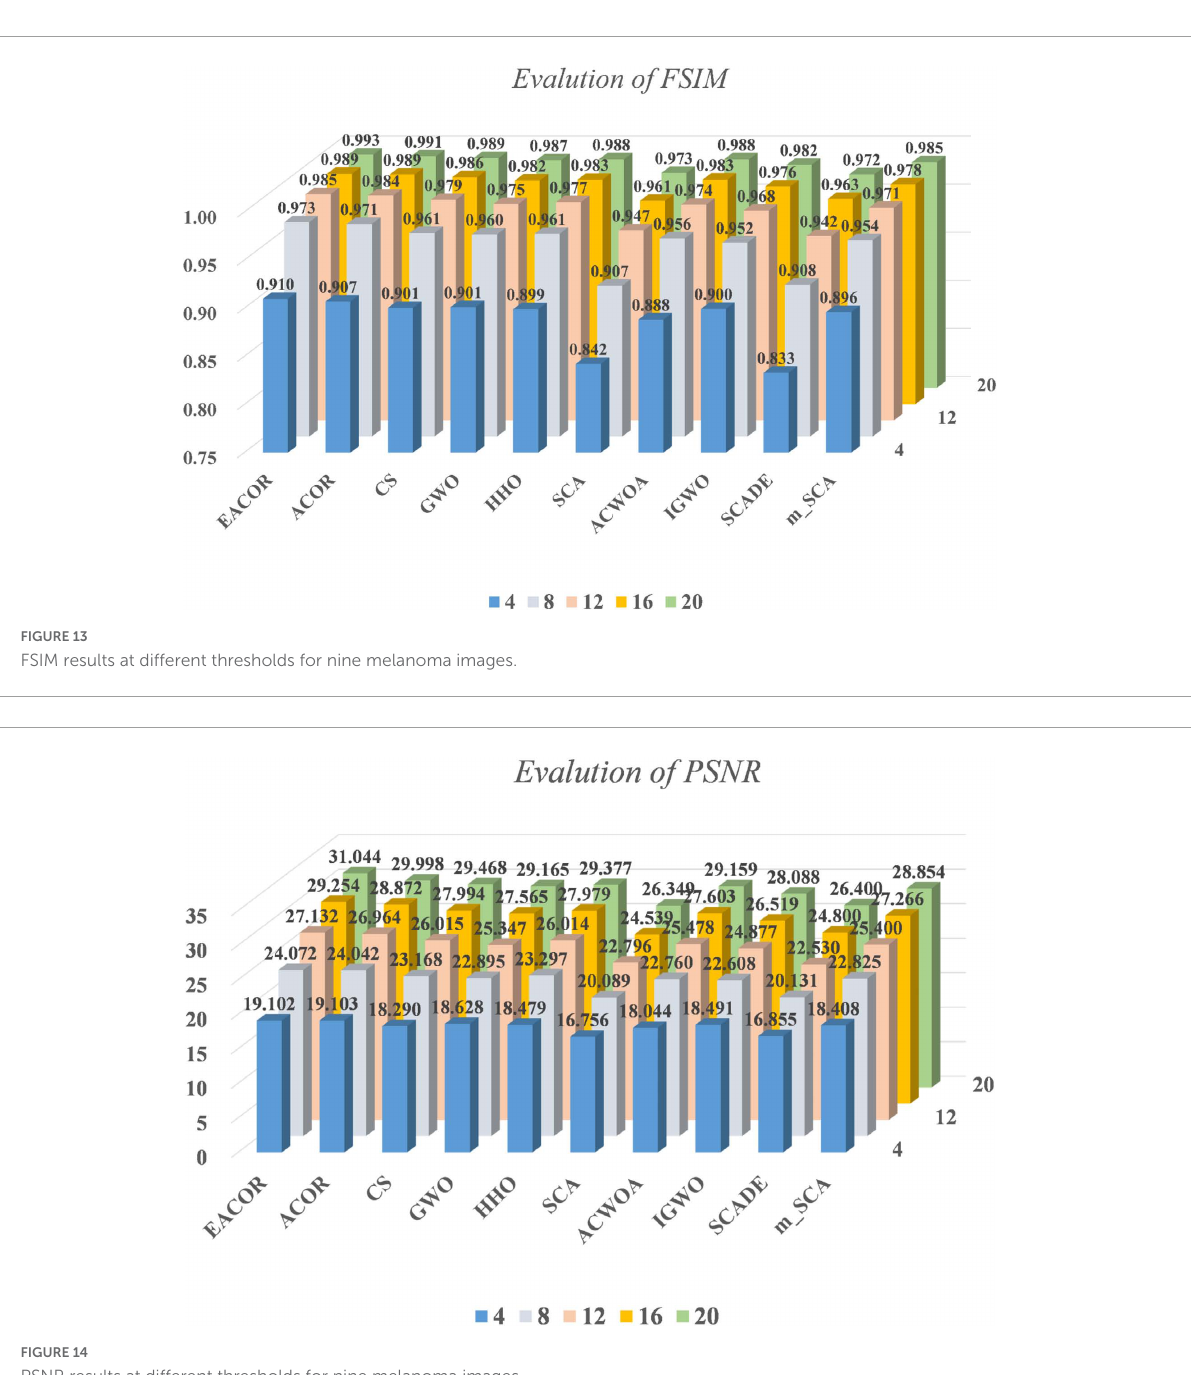
FIGURE14 PSNR results at different thresholds for nine melanoma